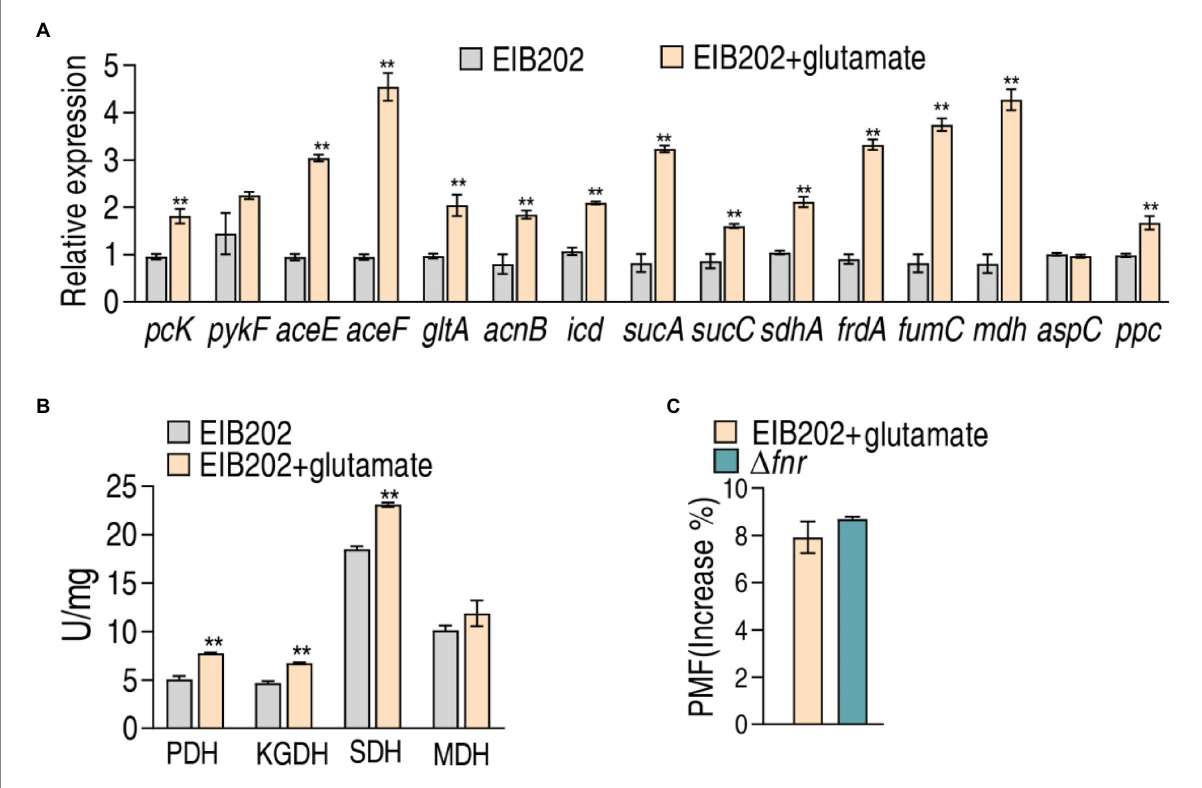
FIGURE 7 Effect of exogenous glutamate on gene expression, enzyme activity, and PMF in EIB202. (A) qRT-PCR for expression of genes of the P cycle in EIB202 with or without 0.3125 mM glutamate. (B) Activity of enzymes of the P cycle in EIB202 with or without 0.3125 mM glutamate. (C) Measurement of PMF in EIB202 with 0.3125 mM glutamate and Δ fnr . Results are displayed as means ± SEM, and significant differences are identified ( ** p < 0.01) as determined by Student’s t -test. At least three biological repeats were carried